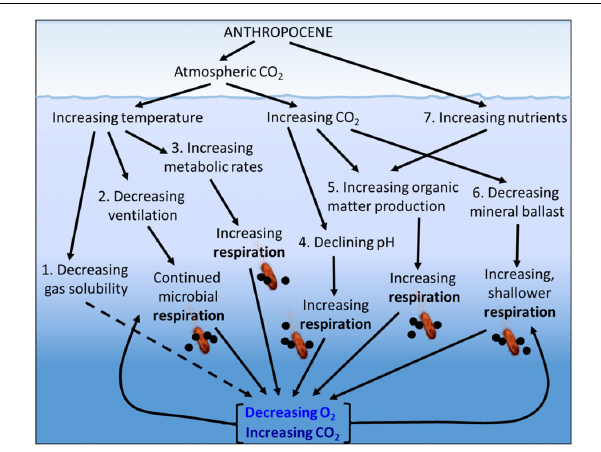
FIGURE 1 | Potential physical, ecological and biogeochemical mechanisms contributing to ocean deoxygenation in the